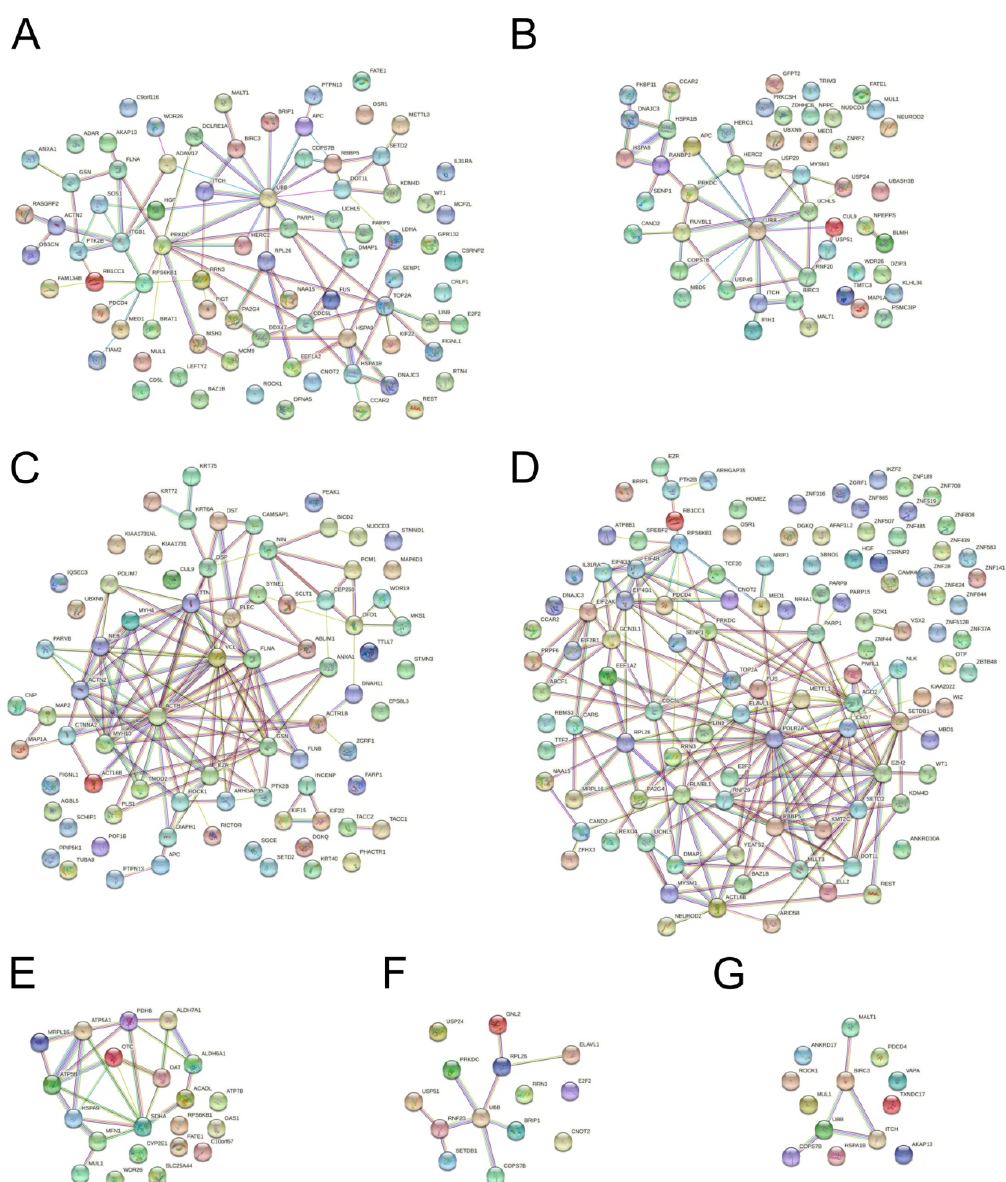
Figure 4. PPI analysis using STRING database: a significant enrichment in groups of Ub-proteins selected by UniProtKB keywords. ( A ) Apoptosis and DNA damage/repair, p =0.0164. ( B ) Folding and ubiquitination, p = 1.6 × 10 − 9 . ( C ) Cytoskeleton, p < 1.0 × 10 − 16 . ( D ) Transcription and translation, p < 1.0 × 10 − 16 . ( E ) Mitochondrial proteins, p =3.1 × 10 − 11 . ( F ) p53, p = 0.0126; and ( G ) NfkB, p = 0.0394.